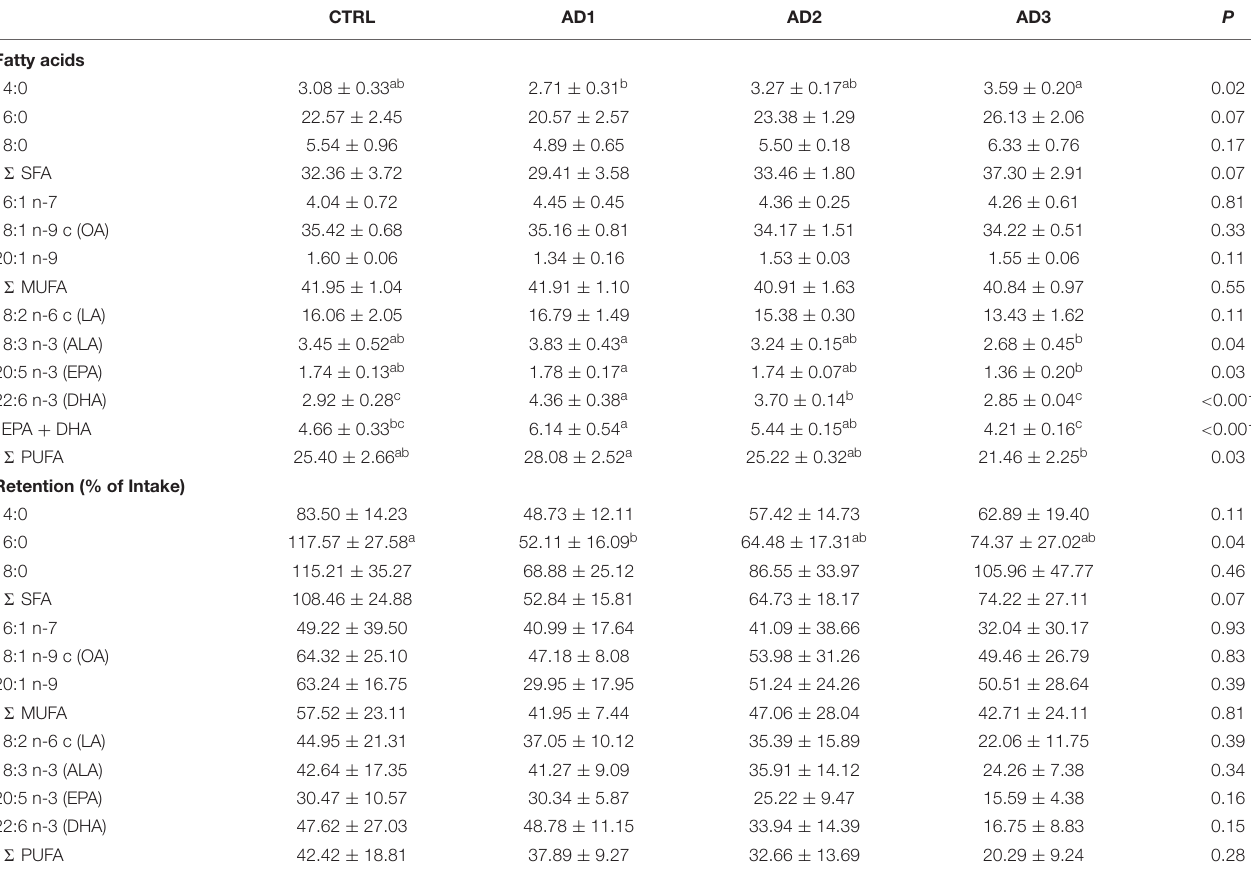
TABLE 6 | Whole-body fatty acid composition (% total fatty acids) and retention (% feed intake). CTRL AD1 AD2 AD3